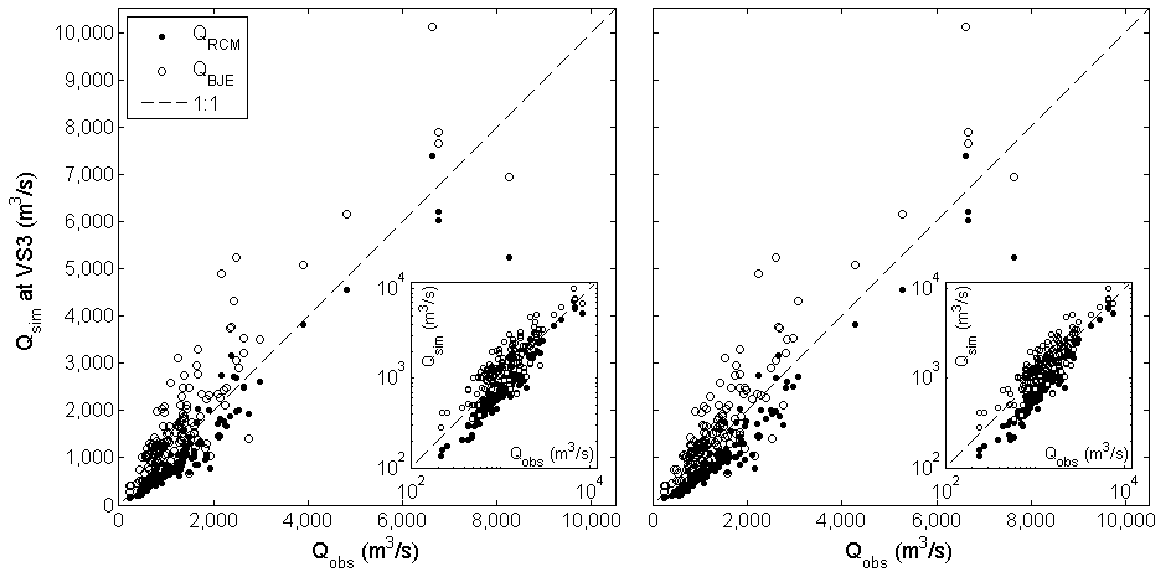
Figure 5. Piacenza-VS3 river reach: comparison between the discharge simulated by using RCM and the Bjerklie formula and the observed in situ discharge for the two gauged stations of ( left ) Sermide and ( right ) Pontelagoscuro. The inset graphs show the same data on a logarithmic